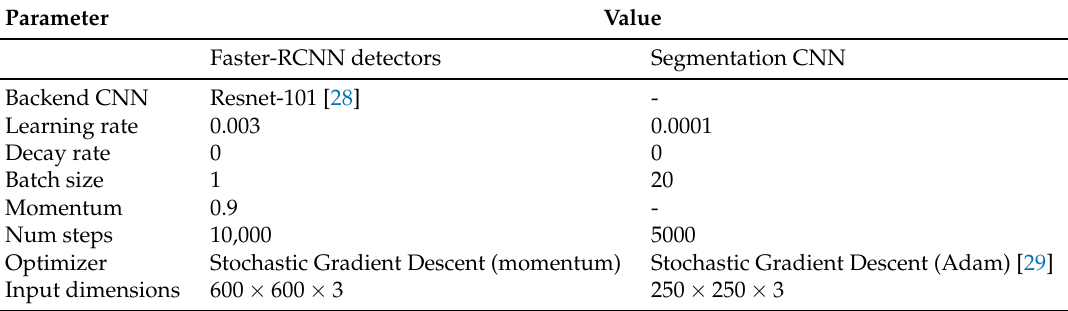
Table 1. Parameters for training the Faster-RCNN stump and log detectors and log segmentation